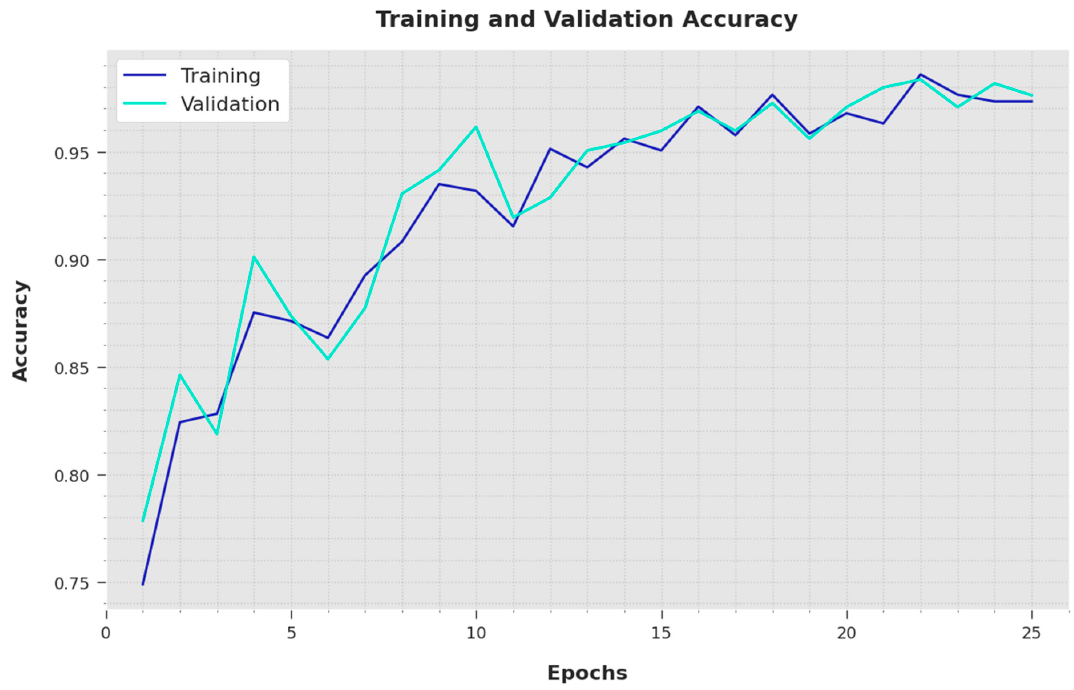
Figure 6. TA and VA analyses results of the IBESSDL-BCHI approach. Both the Training Loss (TL) and Validation Loss (VL) values attained by the proposed IBESSDL-BCHI methodology using the test data are depicted in Figure 7. The outcomes illustrate that the proposed IBESSDL-BCHI technique demonstrated minimal TL and VL values, while the VL values seemed to be smaller than the TL values.